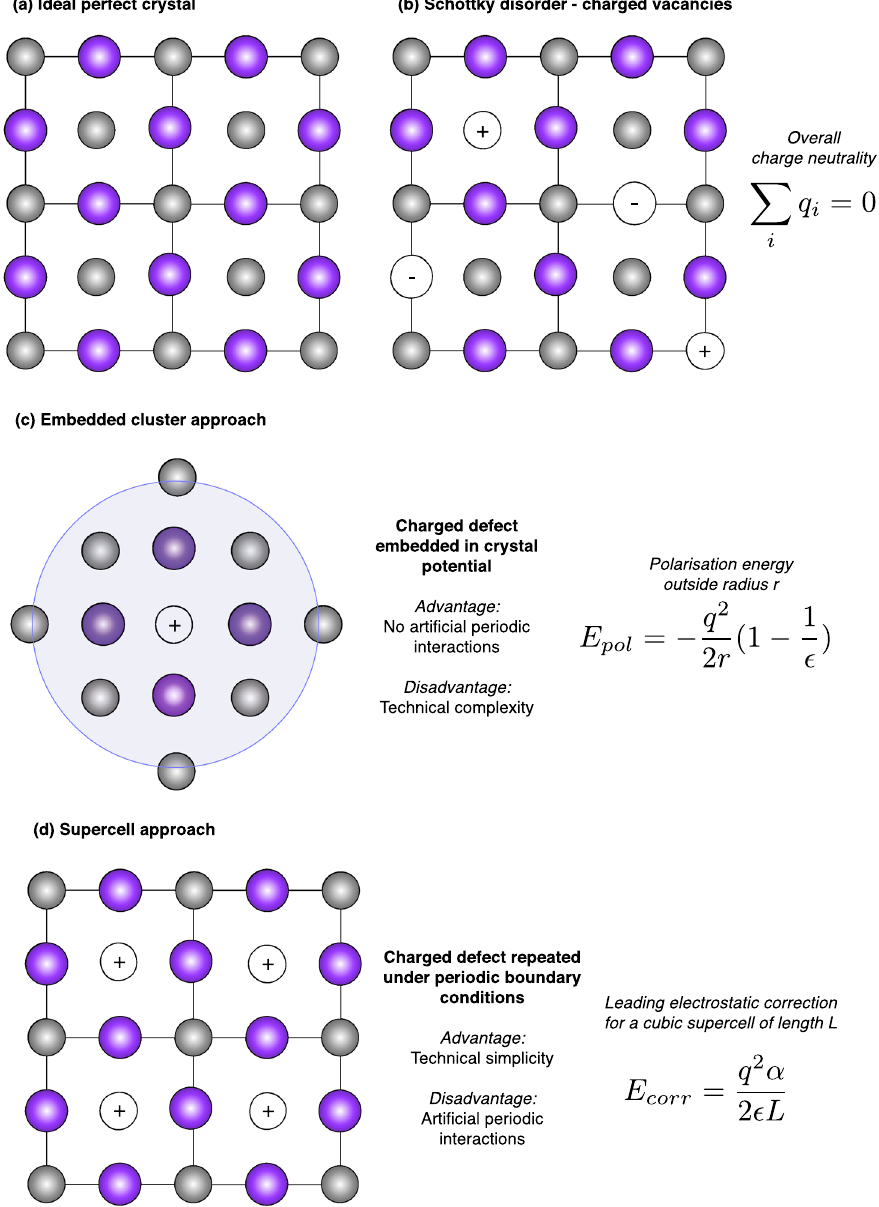
Fig. 1 Defect modelling. Illustration of a a perfect crystal and b a crystal containing a balanced concentration of charged vacancies. The properties of such point defects could be modelled as c an isolated or d a periodic array of charged centres in a host